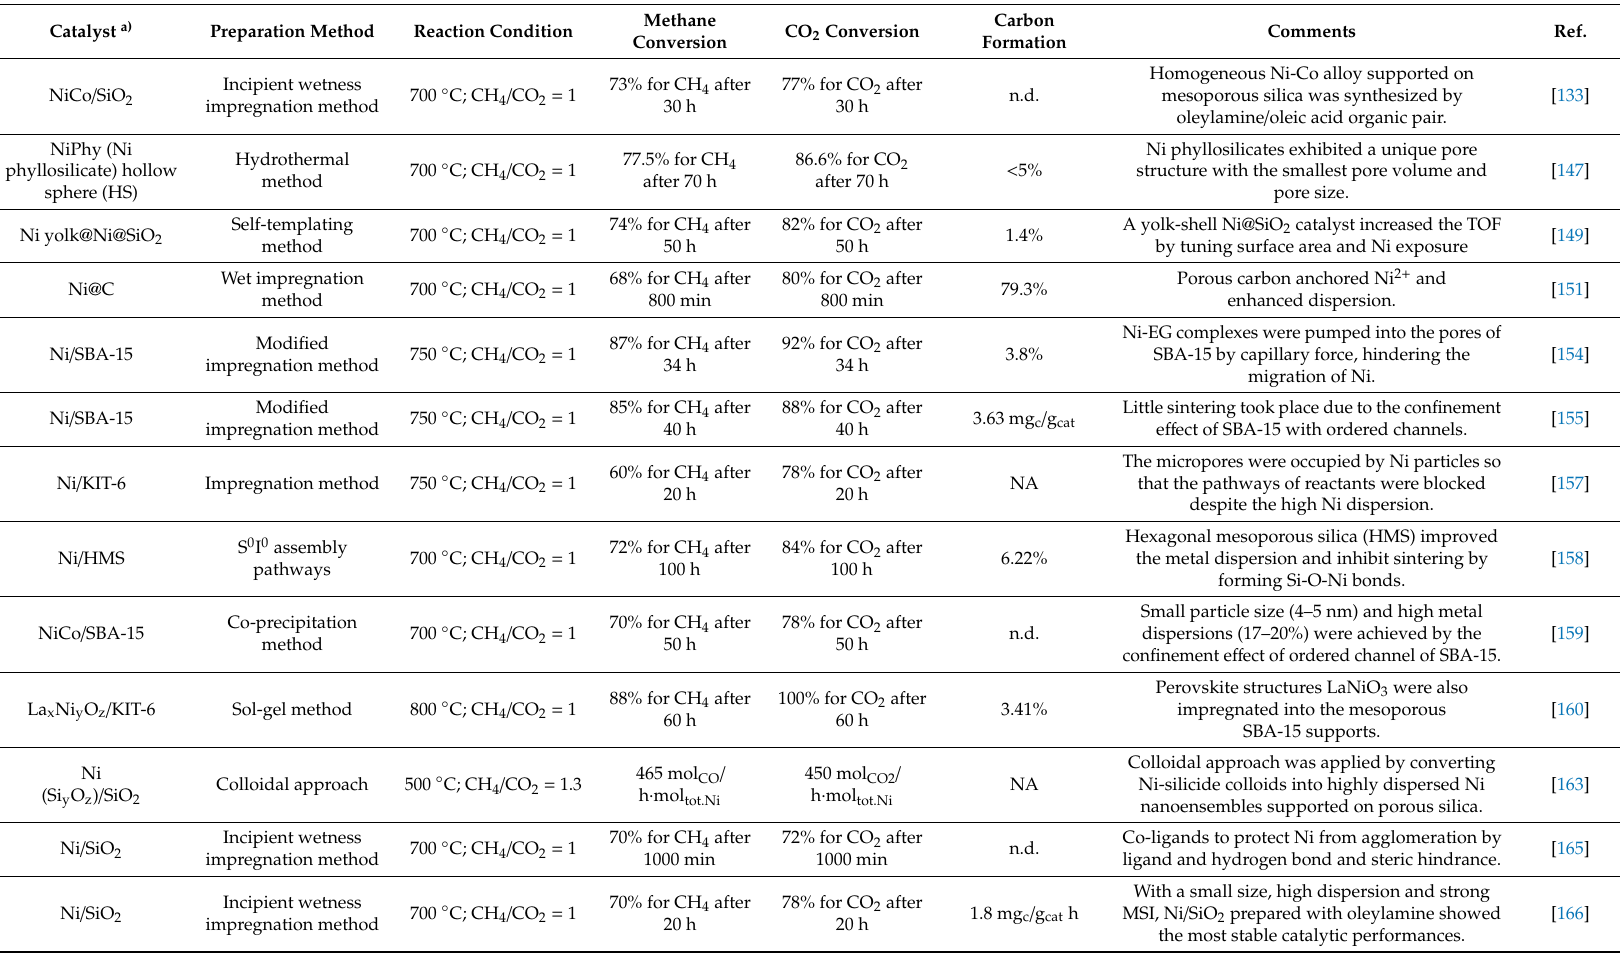
Table 4. A summary of structural optimization e ff ects on the catalytic performances of Ni-based catalysts for DRM